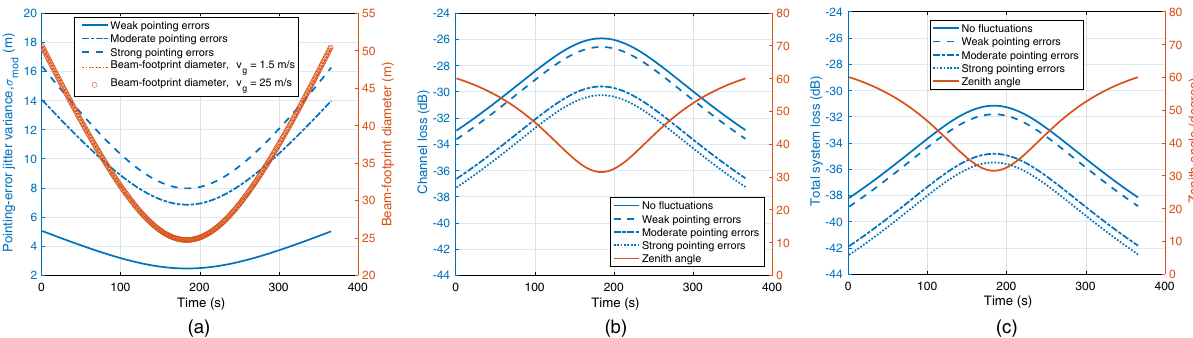
Fig. 6 Physical channel characteristics and losses of the considered LEO satellite pass. Using data from the satellite pass in Fig. 1a, we theoretically investigate the pointing-error beam jitters and losses. In a , we plot the beam-jitter variances with different pointing-error levels versus the received beam- footprint diameter under different ground wind speeds. The footprint diameter is two times the equivalent beam-width (i.e., beam radius) at the ground station calculated as in Eq. (14), with the radius of the receiving telescope aperture a = 0.5 m. The beam-jitter variance, i.e., σ mod , is calculated by Eq. (18). The solid, dashed-dotted, and dashed navy-blue curves indicate the weak, moderate, and strong pointing errors, respectively. The dotted orange curve and the orange curve with round markers represent the footprint diameters when the ground wind speeds v g = 1.5 m/s and v g = 25 m/s, respectively. In b , c , the mean channel loss and total system loss are respectively investigated versus zenith angle under different pointing-error levels and compared with the case of no fl uctuations. The solid, dashed, dashed-dotted, and dotted navy-blue curves indicate losses under no fl uctuations, weak, moderate, and strong pointing errors, respectively. The solid orange curve shows the zenith angle during the satellite pass. From a to c , the three levels of pointing errors are de fi ned as weak ( μ θ ¼ μ θ ¼ 0, σ θ ¼ σ θ ¼ θ = 5), moderate ( μ θ ¼ θ = 5, μ θ ¼ θ = 3, σ θ ¼ σ θ ¼ θ = 2), and strong ( μ θ ¼ θ = 5, μ θ ¼ θ = 3, h i x y x y x y x y x y σ θ = 1 : 5, σ θ = 2). For the case of no fl uctuations (i.e., no turbulence and pointing errors), the channel and system losses can be derived with E η θ x ¼ θ y ¼ p replaced by η p = A 0 , with A 0 de fi ned in Eq.